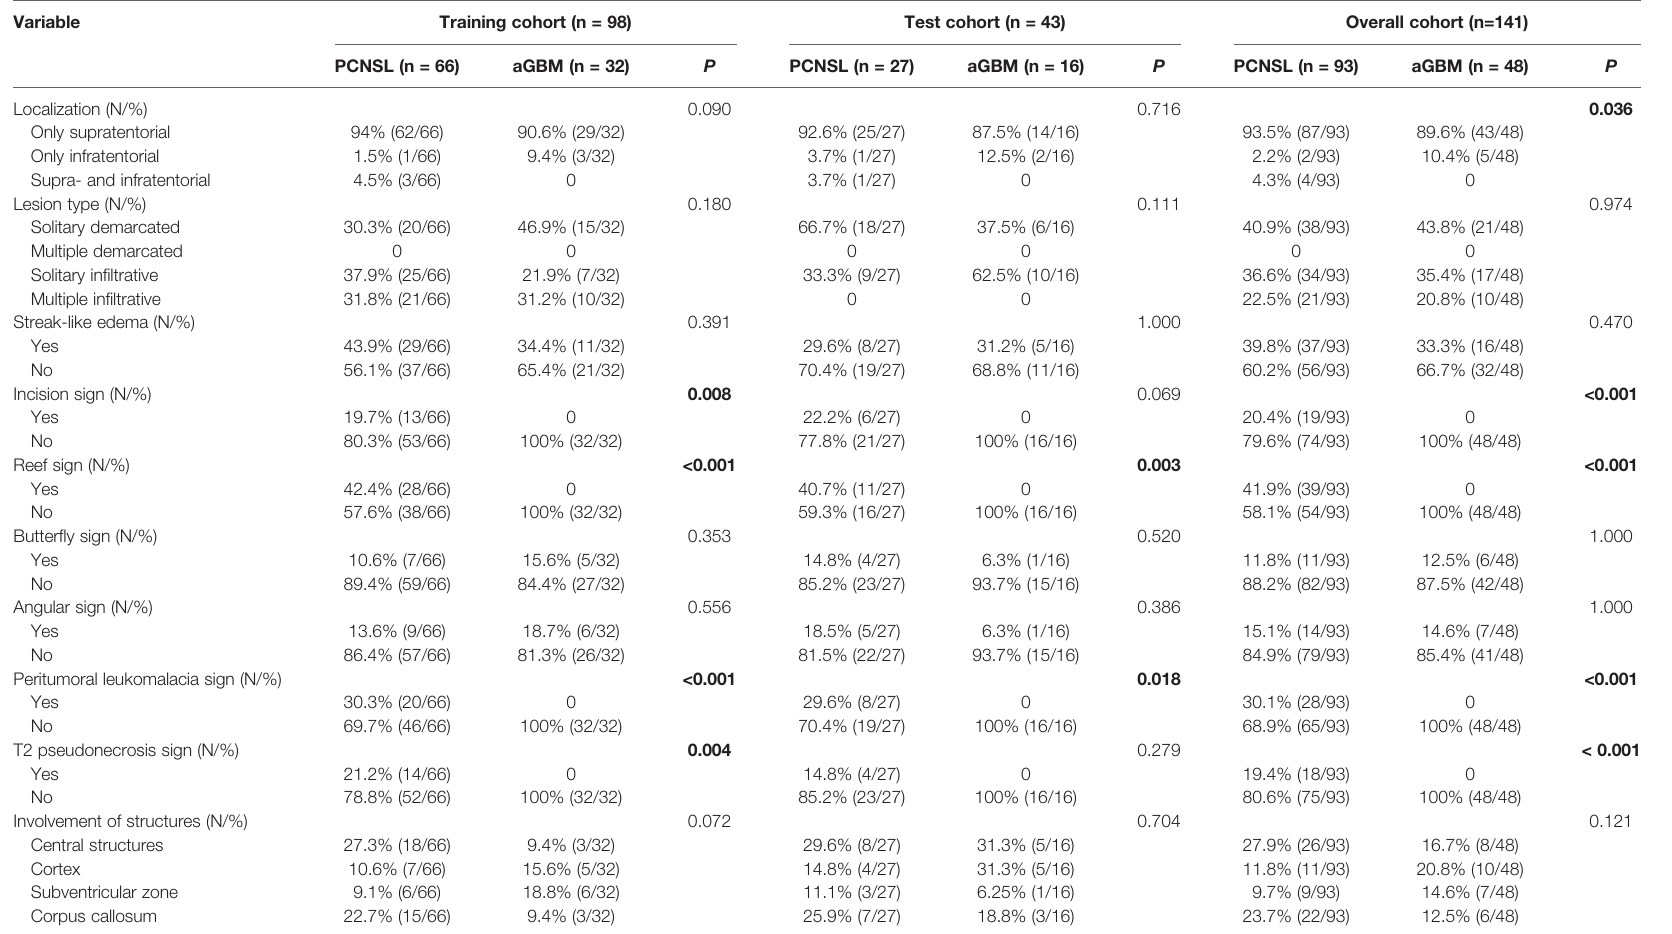
TABLE 3 | MRI morphological features in PCNSL and